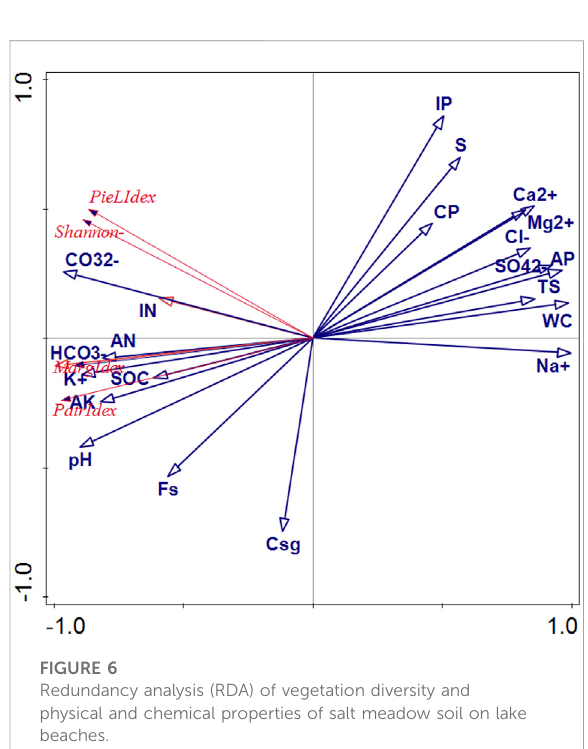
FIGURE 6 Redundancy analysis (RDA) of vegetation diversity and physical and chemical properties of salt meadow soil on lake